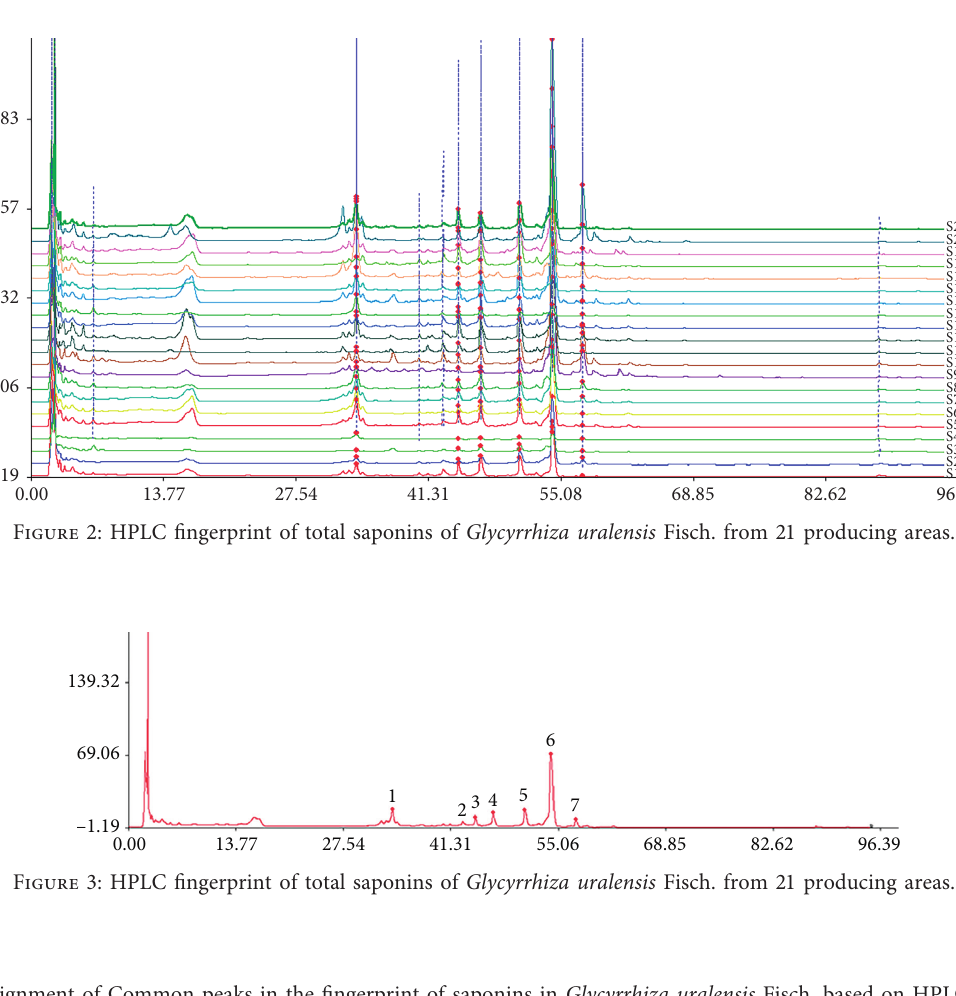
Table 1: Assignment of Common peaks in the fingerprint of saponins in Glycyrrhiza uralensis Fisch. based on HPLC-Q-TOF/MS. Peak number